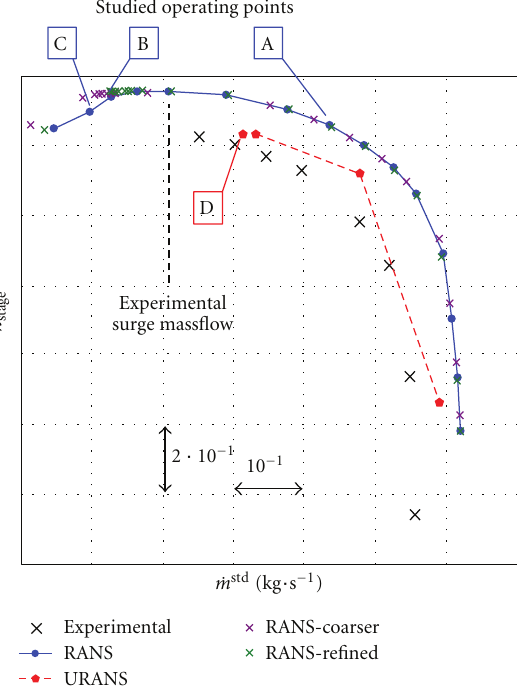
Figure 2: Total-to-static compressor stage pressure